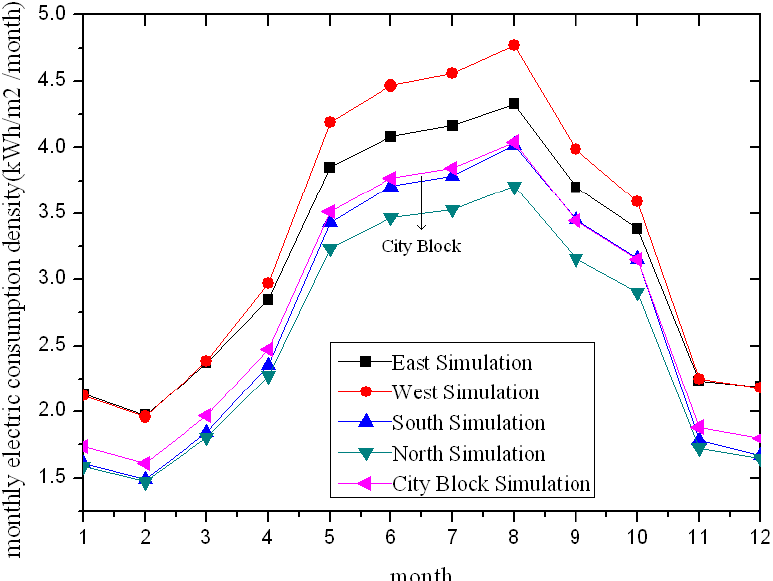
Figure 4. Monthly energy consumption densities of